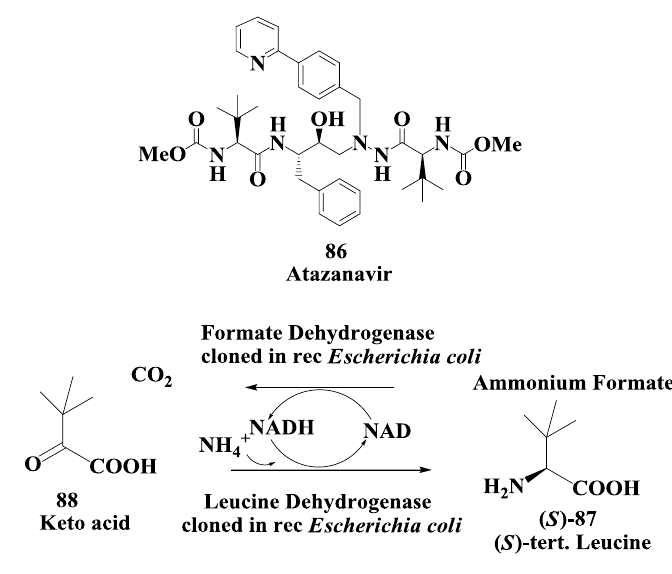
Figure 22. Atazanavir (anti-viral agent): Enzymatic synthesis of ( S